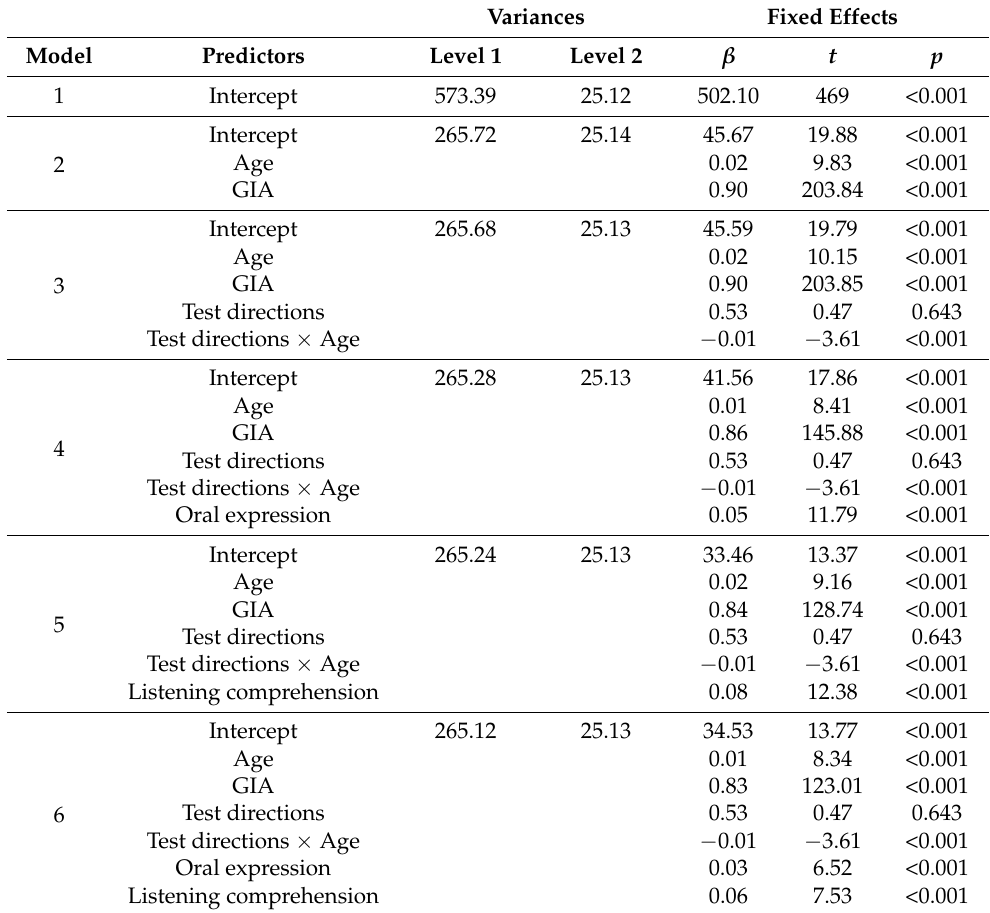
Table 2. A Summary of the Results from the Mixed-Effects